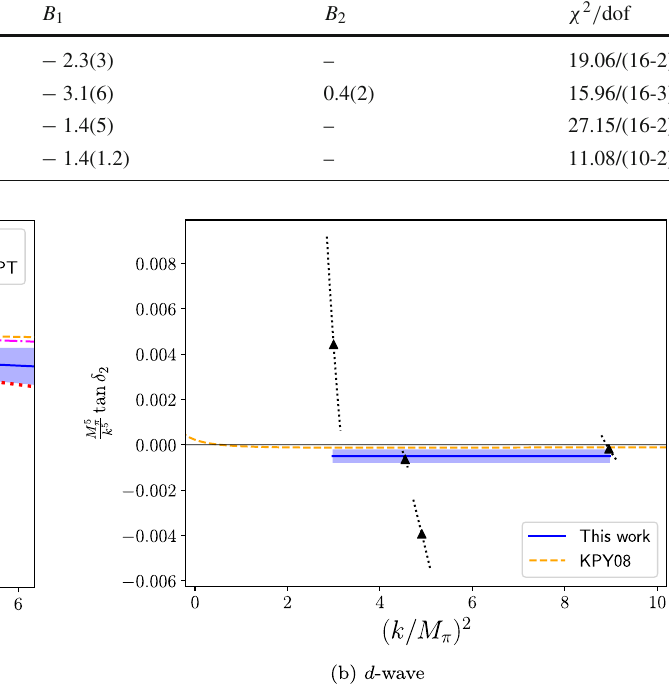
+ and A 1 irreps 1